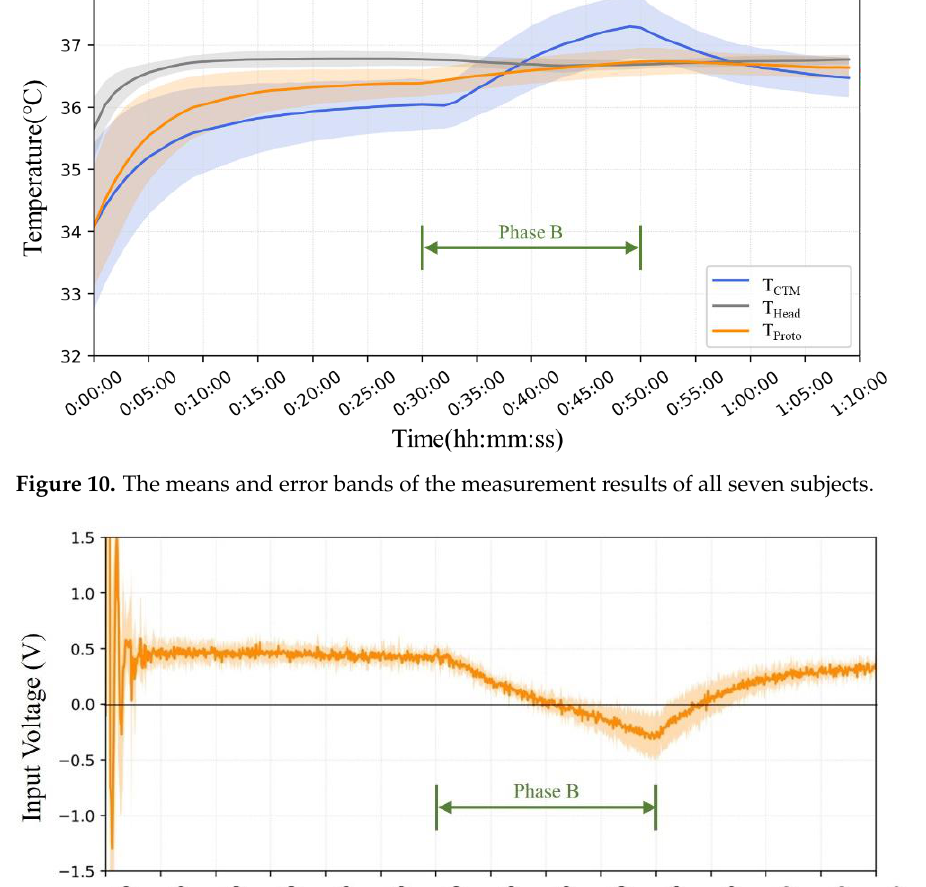
Figure 10. The means and error bands of the measurement results of all seven subjects.